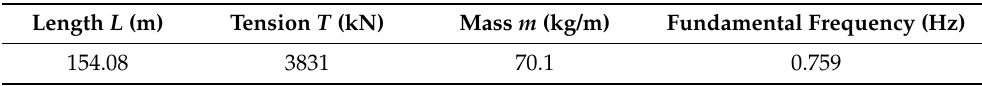
Table 1. Parameters of the cable for the present